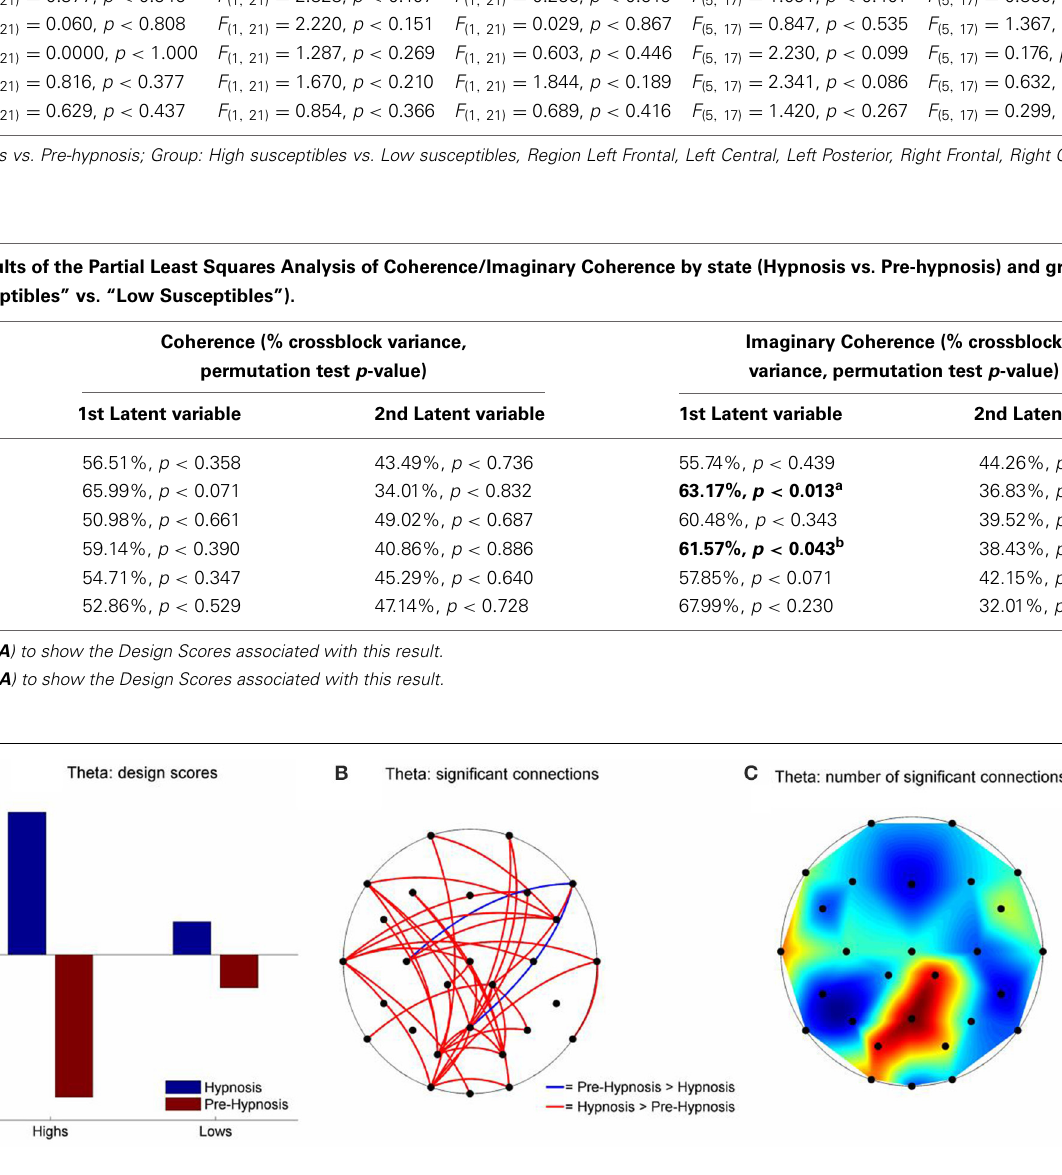
Table 1 | Results of the ANOVA on the EEG amplitude by STATE, GROUP, and REGION. State Group State × Group State × Region State × Region × Group Delta